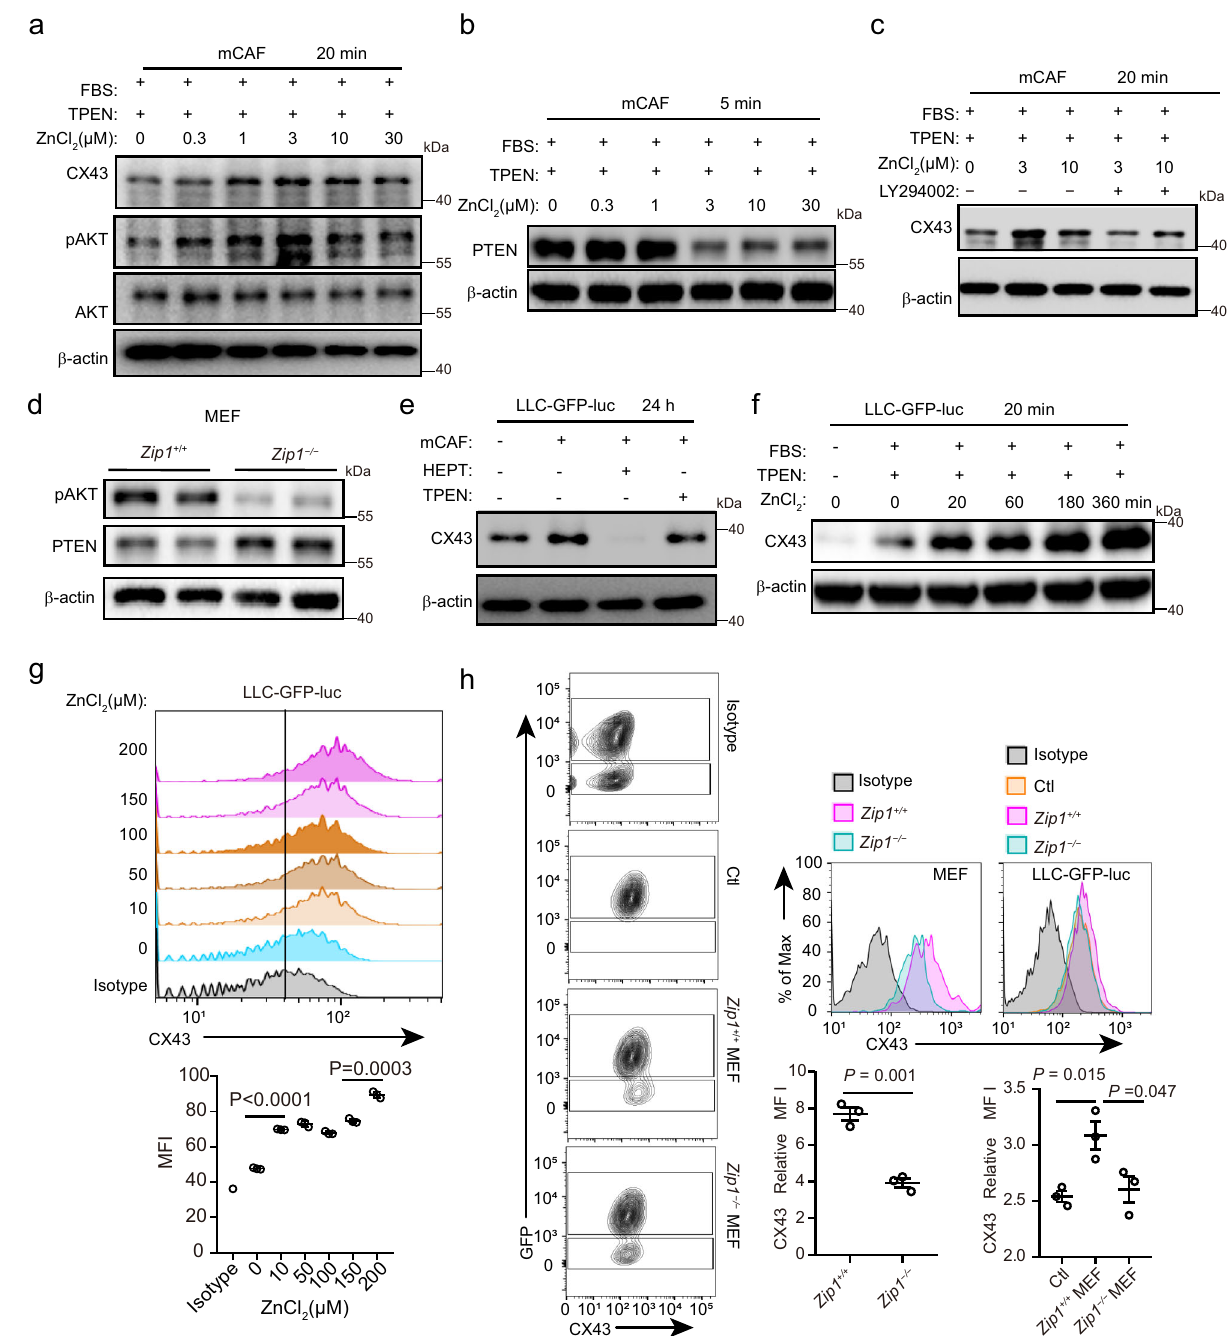
β -actin was used as control. The samples derived from the same experiment and blots were processed in parallel. A representative result from four independent experiments is shown. f Expression of CX43 in LLC-GFP-luc cells stimulated with ZnCl 2 (30 μ M) for different times under indicated conditions. β -actin was used as control. The samples derived from the same experiment and blots wereprocessed in parallel. A representative result from three independent experiments is shown. g Expression of CX43 on the cell surface of LLC-GFP-luc tumour cells treated with different concentrations of ZnCl 2 for 4h in DMEM+10%FBS+5 μ M TPEN. Data are presented as mean±SEM, n =3 for each group. Two-tailed t -test. h Expression of CX43 on the cell surface of Zip1 +/+ and Zip1 − / − MEFs and LLC-GFP-luc cells